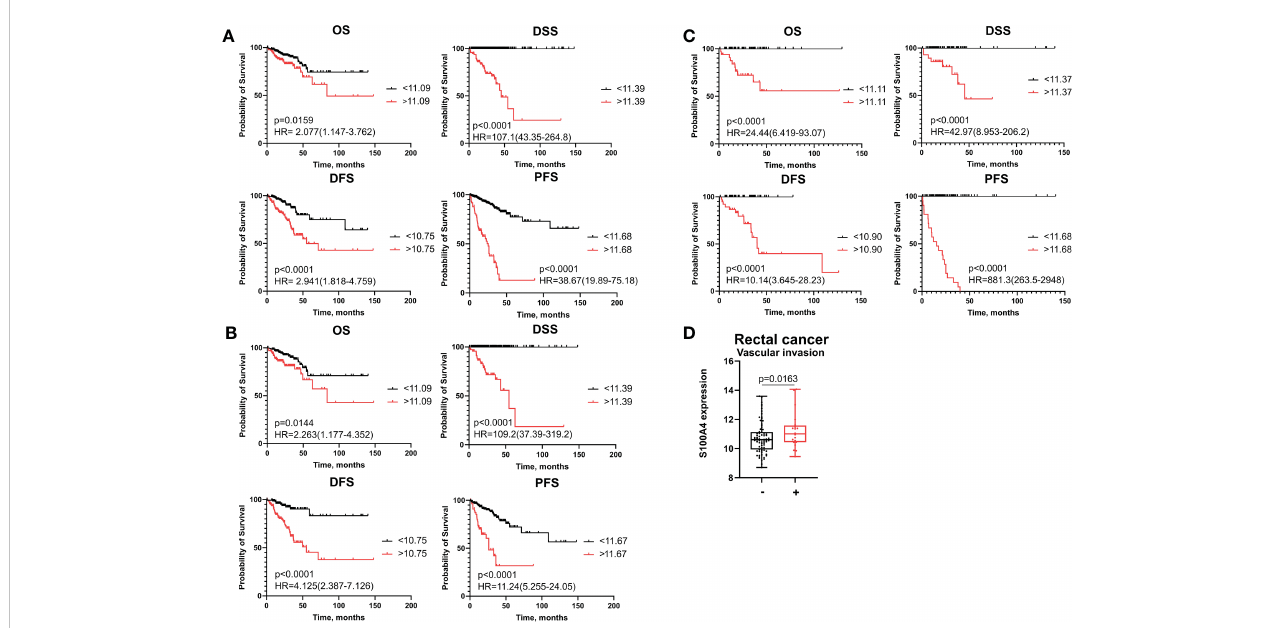
FIGURE 1 S100A4 mRNA expression is an unfavorable prognostic factor for colon and rectal cancer patients. (A) Kaplan – Meier curve of TCGA survival data (OS, DSS, DFS, and PFS) for high-risk and low-risk patients in combined CRC group. (B) Kaplan – Meier curve of TCGA survival data for high-risk and low-risk groups in colon cancer patients. (C) Kaplan – Meier curve of TCGA survival data for high-risk and low-risk groups of rectal cancer patients. Log-rank test p-values are shown in Kaplan – Meier curves. (D) S100A4 mRNA expression is associated with vascular invasion in rectal cancer patients (TCGA-READ data). Mann-Whitney U test was applied. Box plot depicts gene expression (min, Q1, median, Q3,